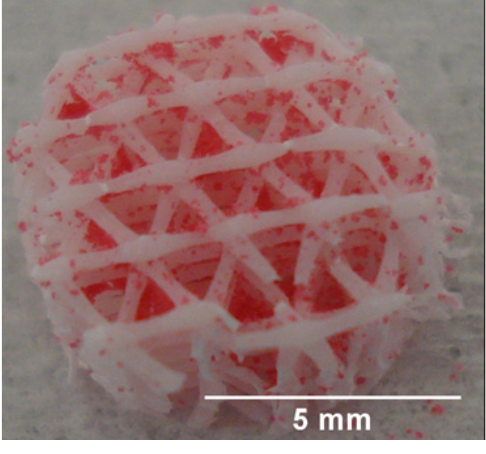
Figure 8. Photographs of 5 mg of PLGA / PLGA-PEG-PLGA microparticles attached